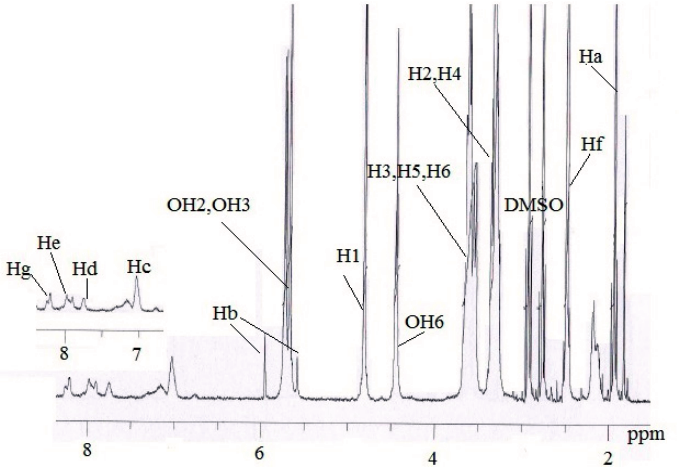
Figure 3. 1 H NMR spectrum of MAA- β -CD.